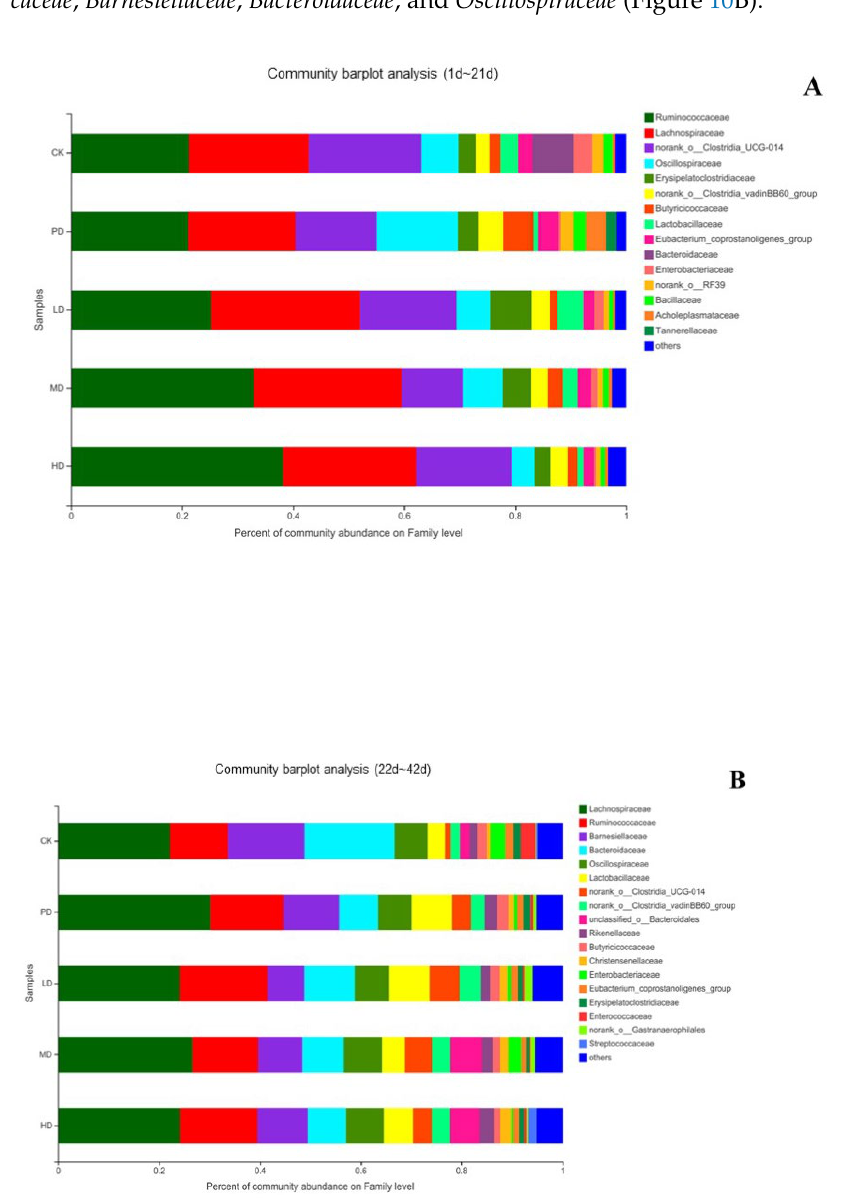
Figure 10. The composition of each group at the family level ( A ): the early stage (1~21d), ( B ): the late stage (22~42d).